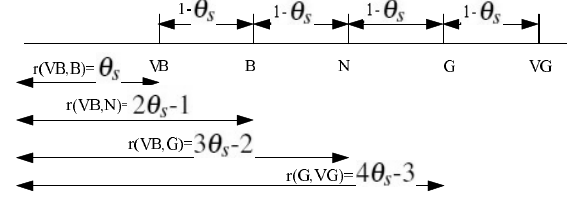
Fig. 1. The similarity relation of the label in La